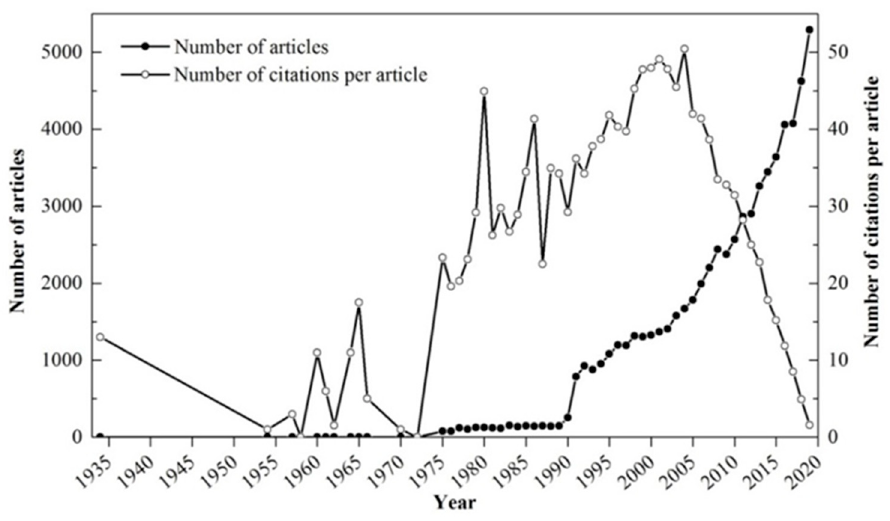
Figure 1. The annual number of articles and citations per article from 1934 to 2019.